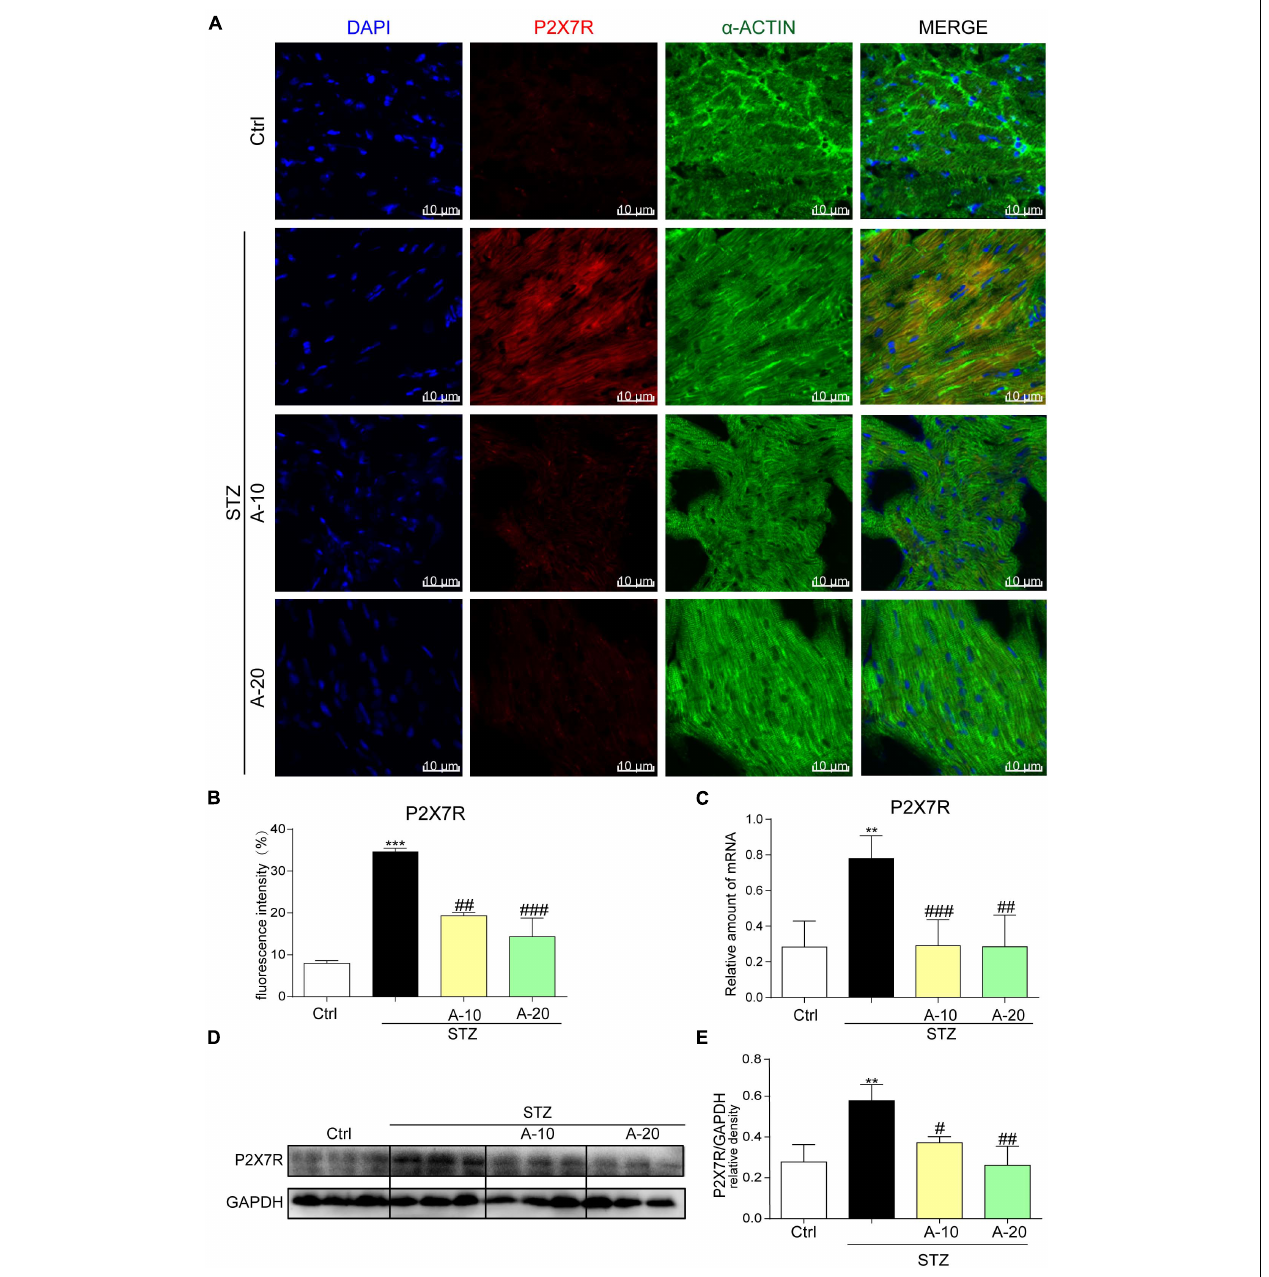
FIGURE 1 | P2X7 receptor expression was increased in the STZ-induced type 1 diabetes model and HG-treated cell model in vitro . Representative images (A) and quantification (B) of immunofluorescence staining for P2X7R in myocardial tissues (400 × magnification). The expression of the P2X7R mRNA (C) and protein (D) with the corresponding statistics (E) (data from three independent experiments were analyzed: * p < 0.05, ** p < 0.01, and *** p < 0.001 compared with the Ctrl; # p < 0.05, ## p < 0.01, and ### p < 0.001 compared with STZ